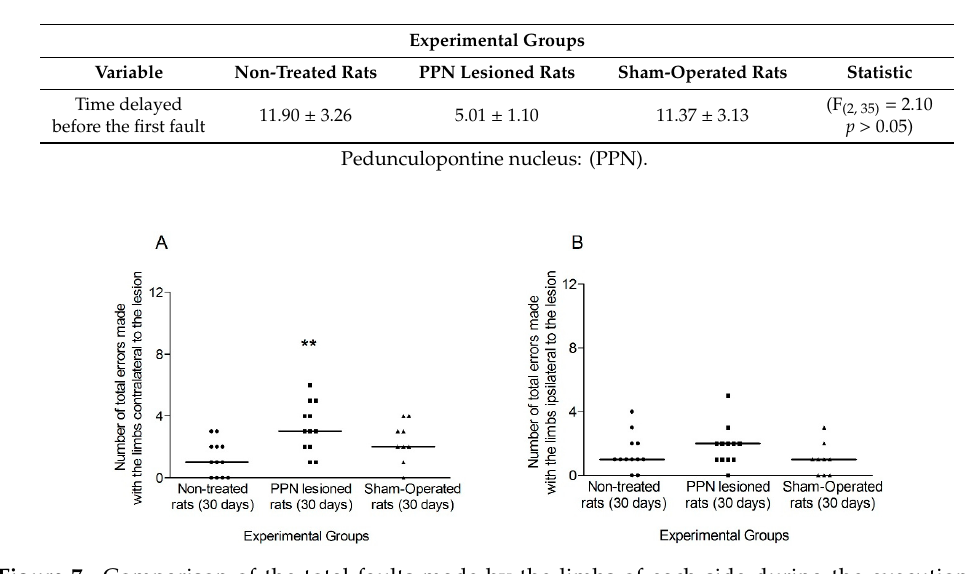
Figure 8. Comparison of the faults made by each limb separately during the execution of grid test, 30 days after pedunculopontine nucleus lesion. ( A ) Faults made by the contralateral forelimb (H (2,33) =